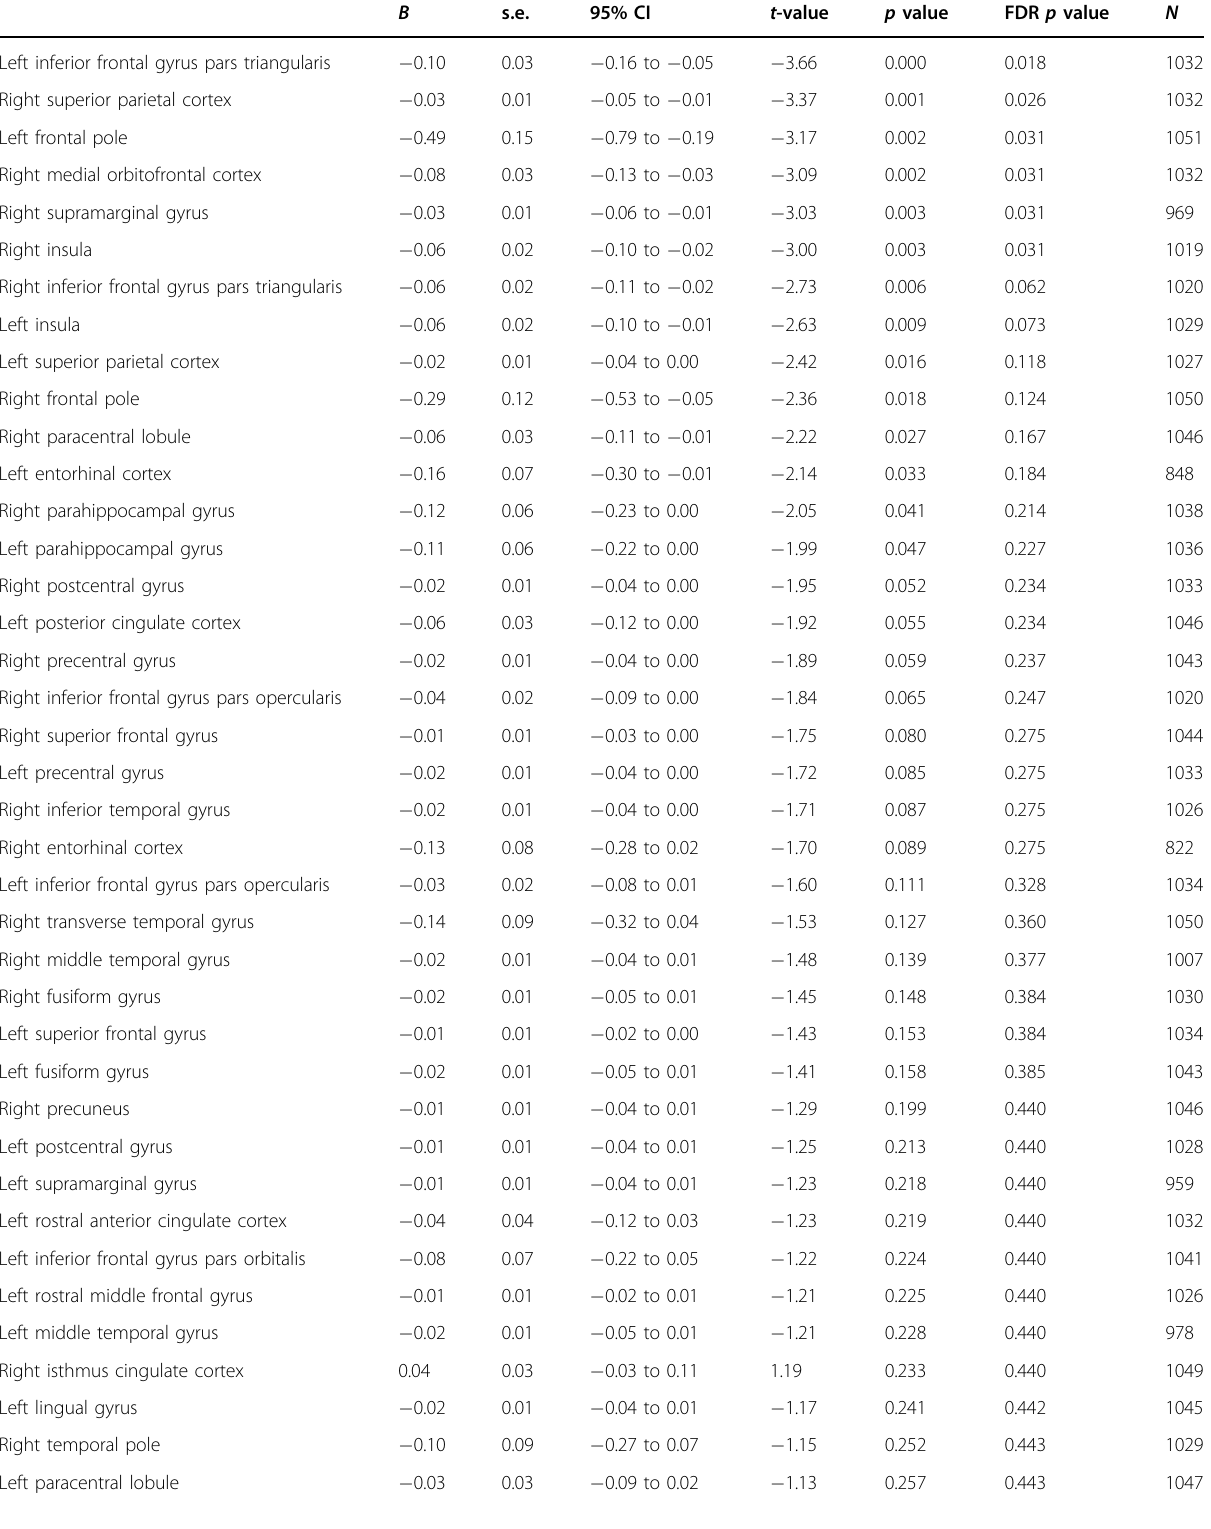
Table 2 Mixed effect regression analyses estimates of the association of insomnia severity with cortical surface areas (HDRS points/cm 2 ) in MDD patients, adjusted for age, sex, insomnia-independent depression severity a , and scanning